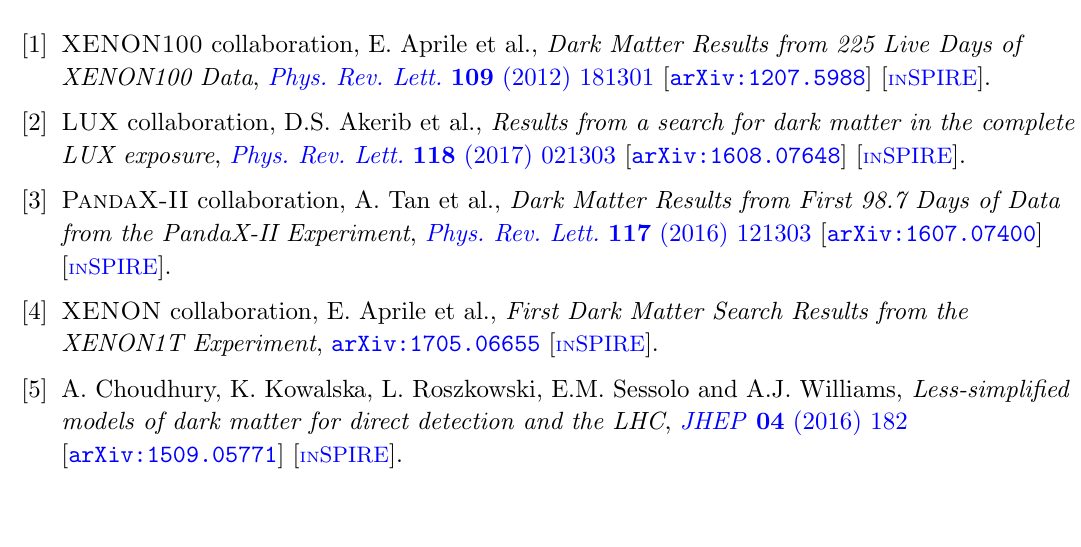
Figure 11 . Left panel: the 95% CL upper limits of (cid:27) SI and old combined likelihood (blue dashed line). Right panel: the 95% CL upper limits of c p and O 4 (ISC). In both panels, the solid lines are for the old combined likelihood but dash lines are the new